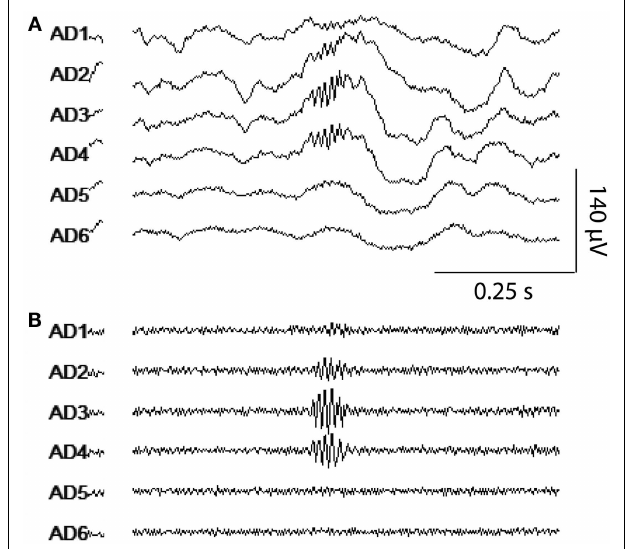
FIGURE 2 | HFO visualization using the clinical viewer . A representative example of an HFO detected in multiple macro-contacts simultaneously is shown. Six adjacent macro-contacts from one amygdalar depth electrode were displayed using the clinical viewer software with wide-band [ (A) ; 5Hz high pass, 60Hz notch] and HFO-band settings [ (B) ; 80Hz high pass, 60Hz